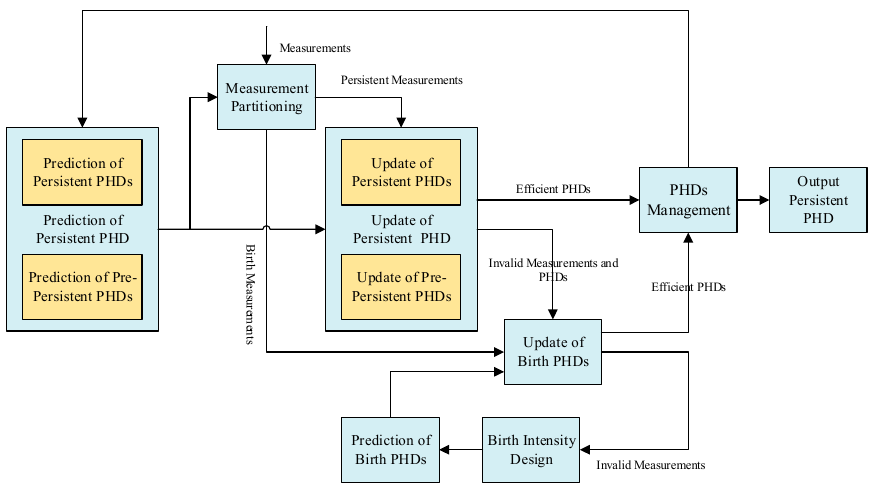
Figure 1. The adaptive collaborative Gaussian Mixture Probability Hypothesis Density (ACo-GMPHD) filter framework.